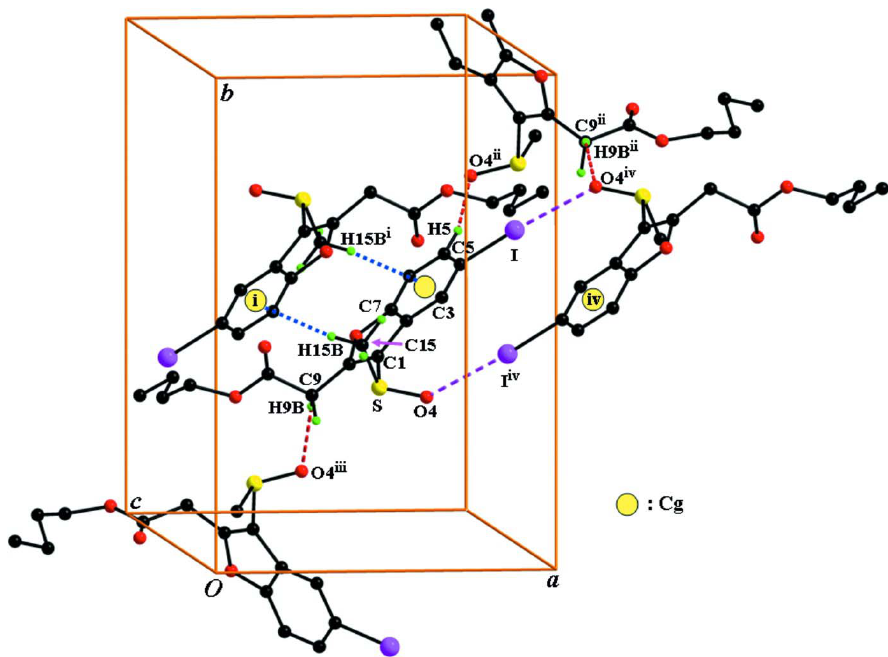
Figure 2 C—H··· π , I···O halogen bond and C—H···O interactions (dotted lines) in the title compound. Cg denotes ring centroid. The disordered component of the oxygen atom of carbonyl group and butyl group, part B, have been omitted for clairty as have H atoms not involved in intermolecular contacts. [Symmetry code: (i) - x +1, - y +1, - z +1 ; (ii) x -1/2, - y +1/2, z